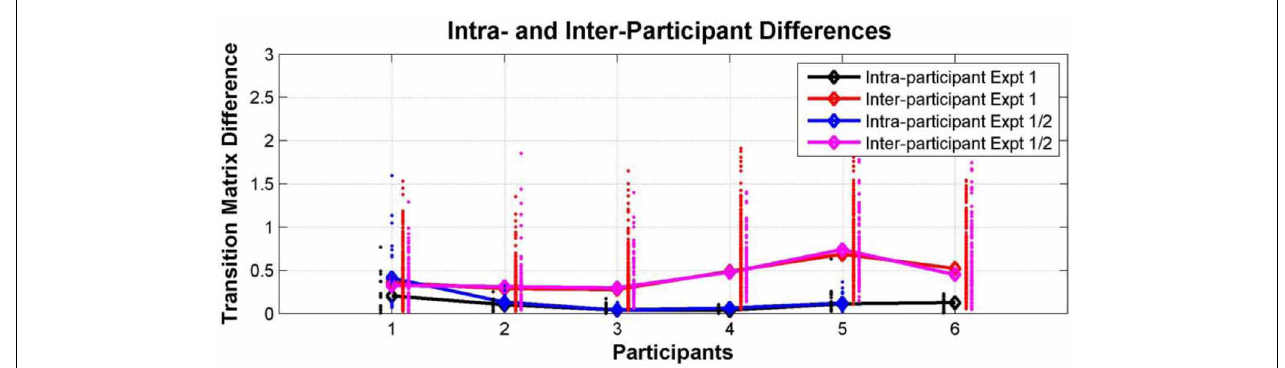
FIGURE 10 | Individual differences within and between Experiments 1 and 2. Comparison between intra- and inter-individual perceptual switching behavior, characterized by participant transition matrices extracted for each participant for each test session, pooling data from all conditions. Differences between transition matrices from the same participant in different sessions in Experiment 1 (black dots; median—black diamonds, line), differences between transition matrices of each participant in